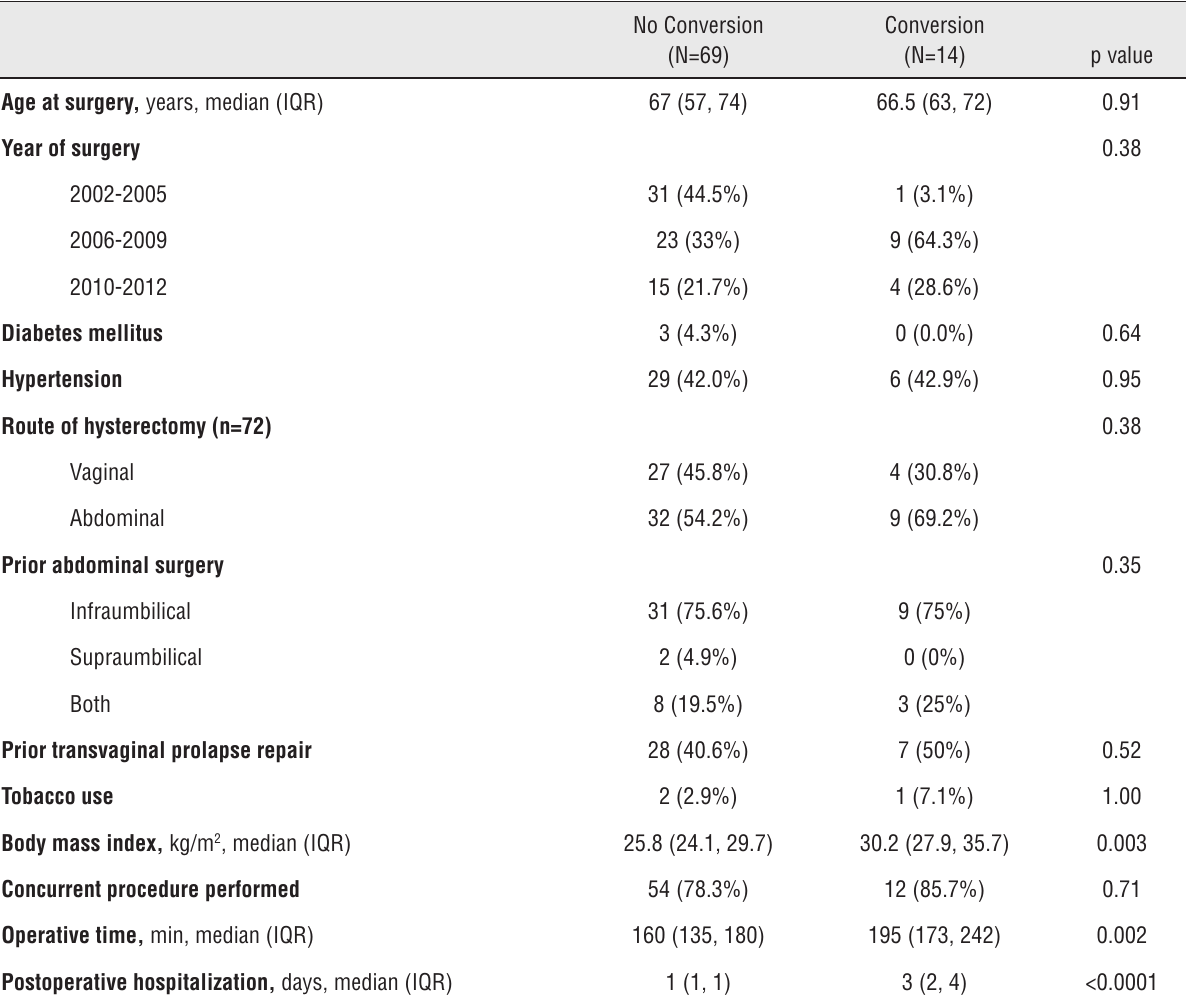
Table 1 - Clinical and demographic information for patient undergoing robotic sacrocolpopexy stratified by requirement for intraoperative